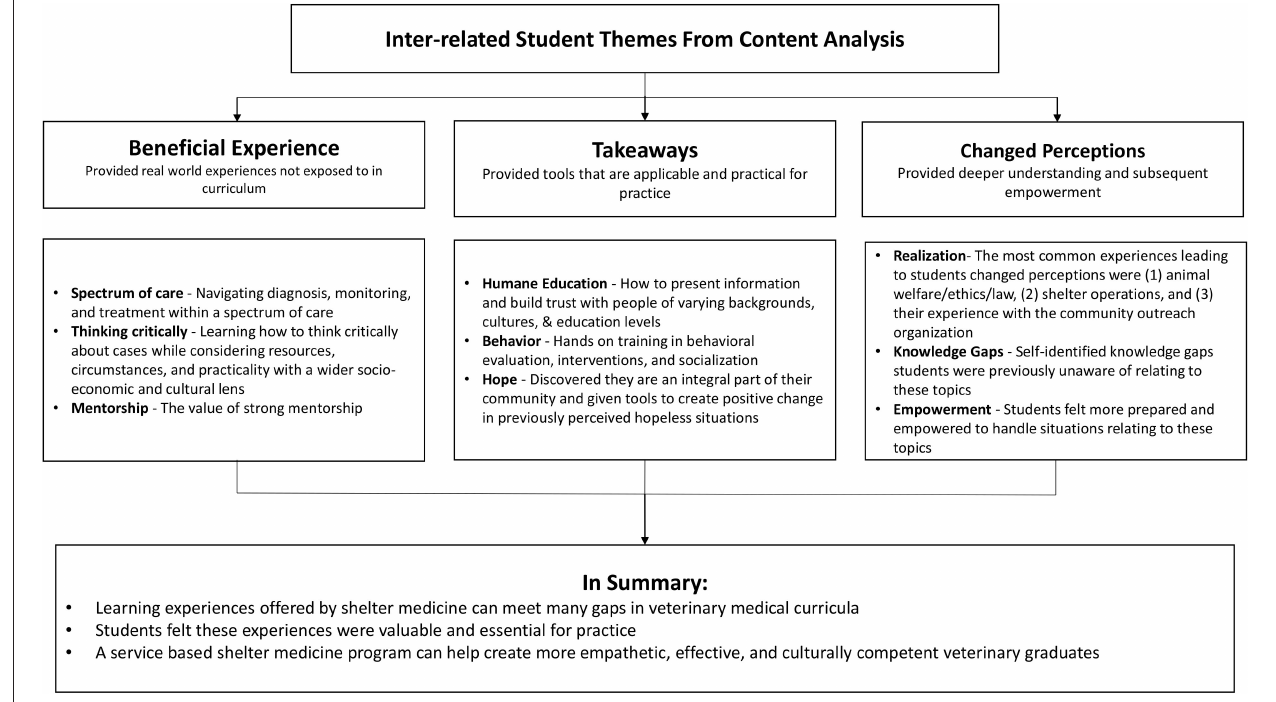
FIGURE 1 | A summary of the three inter-related themes that emerged from the content